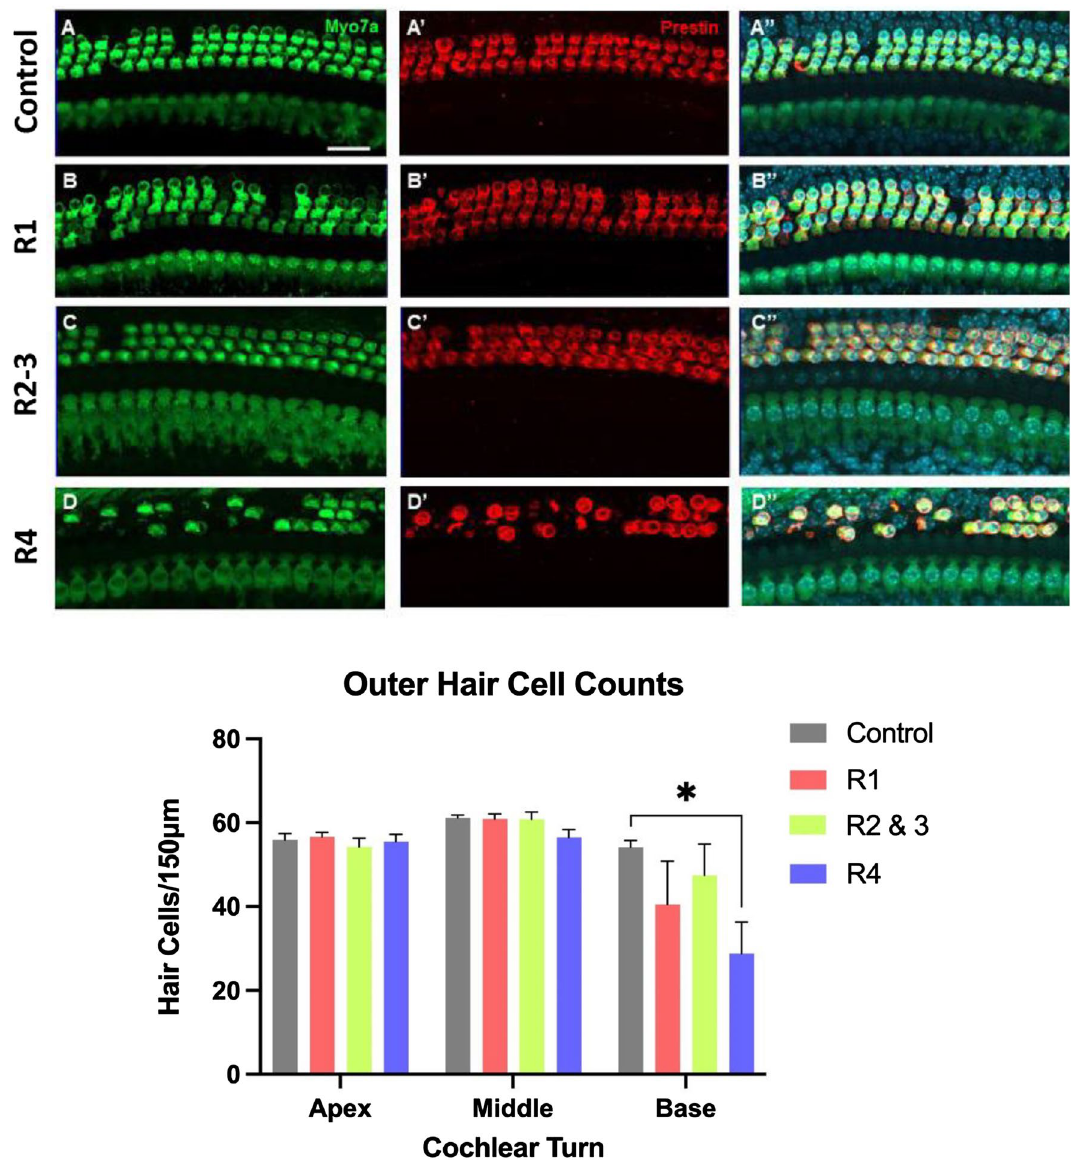
Figure 5. Representative confocal maximum projection images from the basal turn of control ( A – A ”) n = 6, R1 ( B – B ”) n = 4, R2-3 ( C – C ”) n = 5, and R4 ( D – D ”) n = 5 cochleae. Inner and outer hair cells are labeled by myosin VIIa (Myo7a, green) and outer hair cells are labeled by prestin (red). Nuclei are labeled by Hoechst (blue). Scale bar = 20 um. Quantification of outer hair cells in a 150 µm region per cochlear turn. Error bars represent standard error of mean (SEM), * <